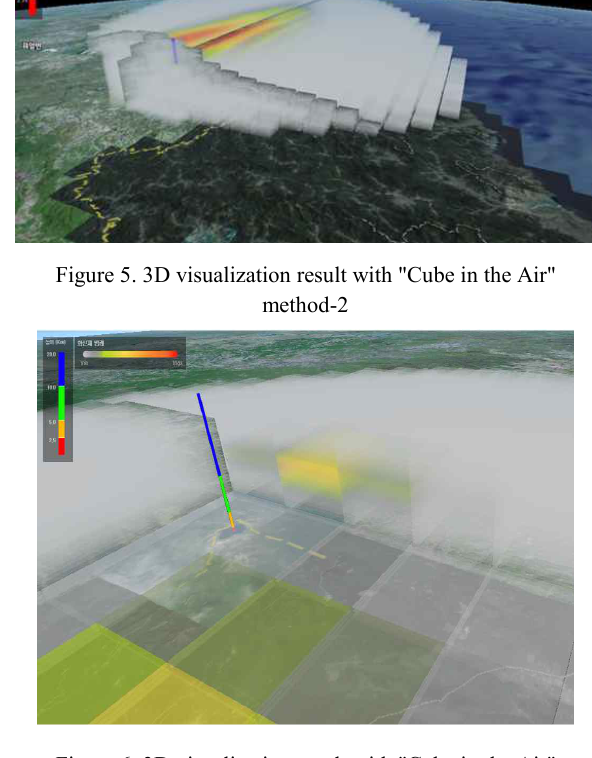
Figure 6. 3D visualization result with "Cube in the Air"